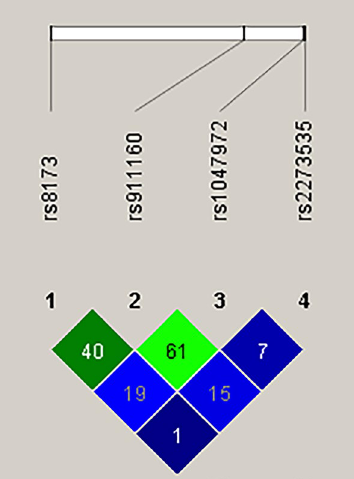
Figure 3. Linkage disequilibrium among single nucleotide polymorphisms in the AURKA gene. The color plot represents Lewontin’s D ′ values and logarithm of odds (LOD). Blue squares, LOD < 2 and D ′ < 1; Green squares, LOD ≥ 2 and D ′ < 1. The values within the squares refer to the Lewontin’s D ′ × 100.